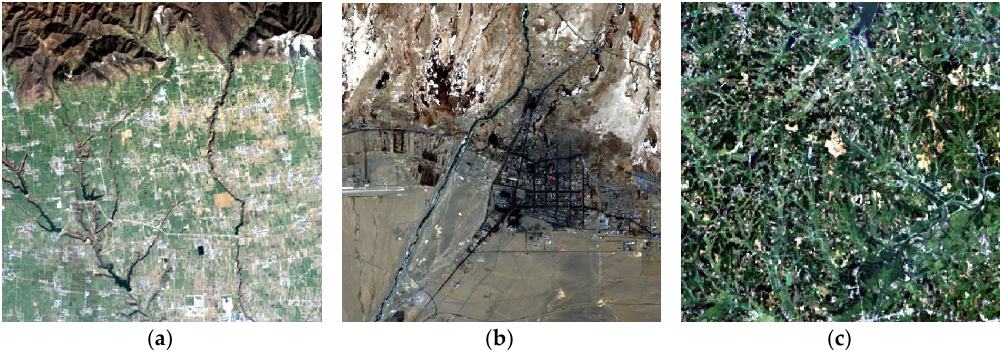
Figure 8. The true color images of study areas. ( a ) study area 1; ( b ) study area 2; ( c ) study area 3. Landsat8 OLI and MOD09GA data were downloaded from the United States Geological Survey (USGS) (see Table 1 for the information about the data) and were used in this study. The differences of acquisition times between Landsat and MODIS images do not exceed one day, which